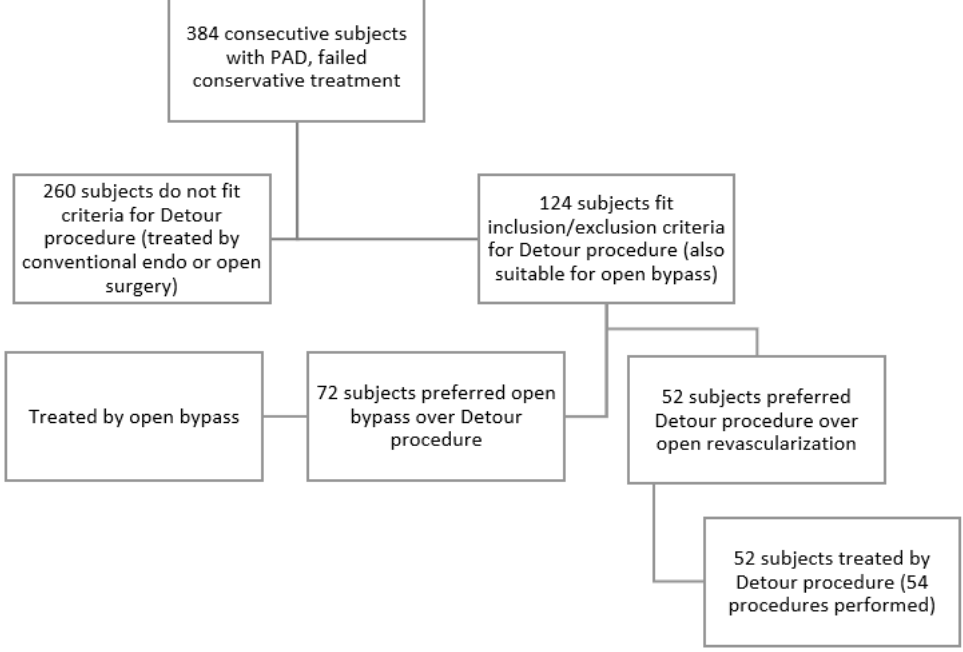
Figure 1. Flow chart depicting patient treatment and selection protocol.